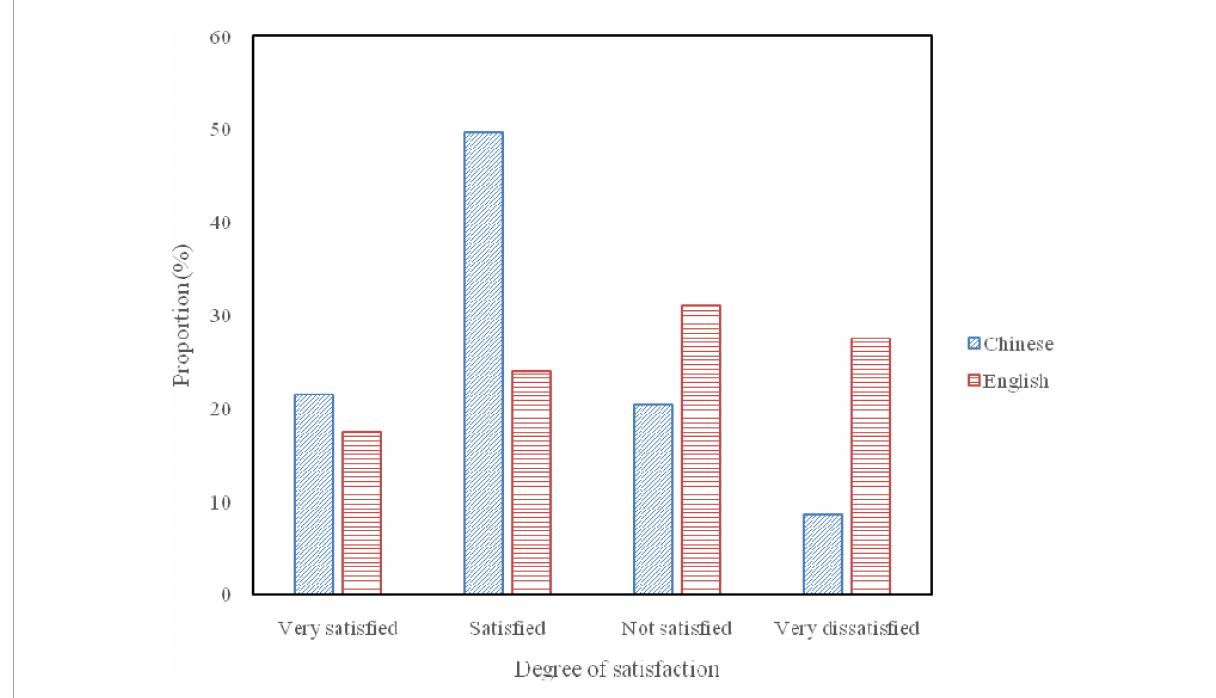
FIGURE7 Statistical chart of the satisfaction data of the second major (Chinese/English) curriculum setting.